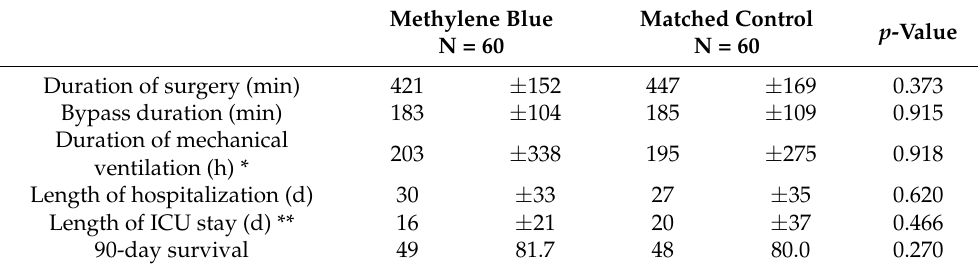
Table 2. Perioperative variables of matched